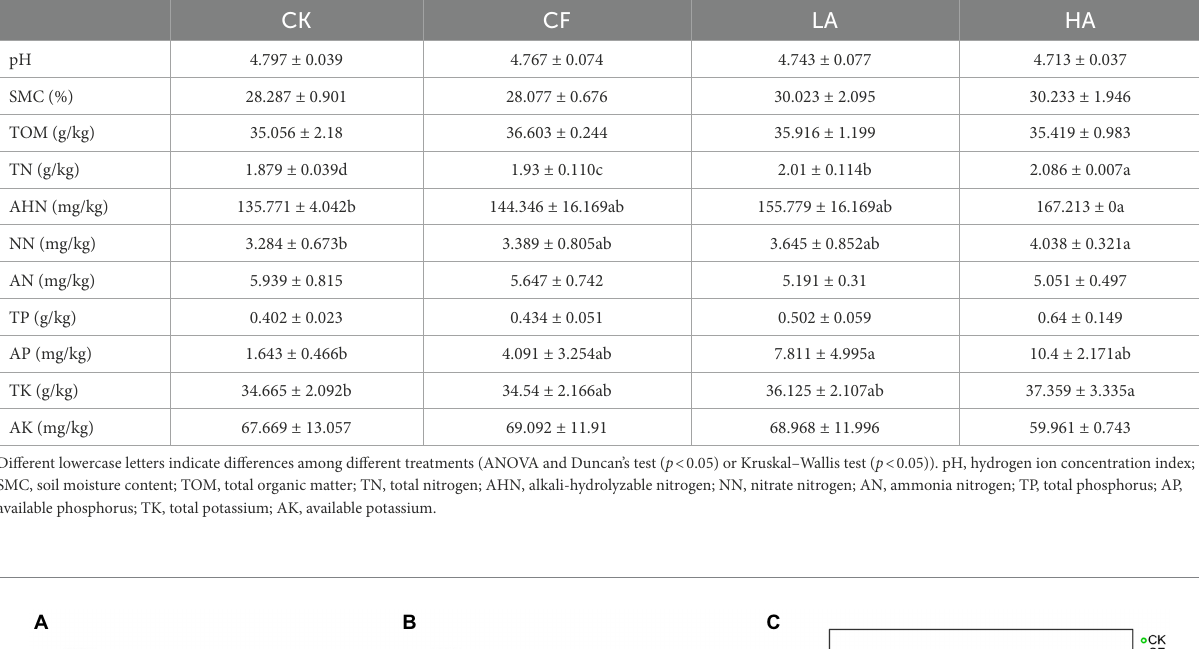
TABLE 1 Effects of different fertilization treatments on soil physicochemical